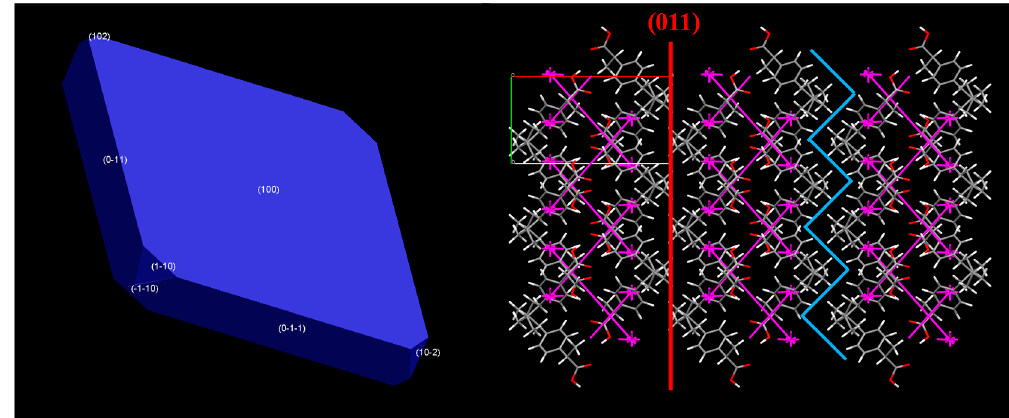
Figure 10. Growth morphology (attachment energy-based) of IBU crystals and energy vector diagrams (EVDs) depicting the total interactions in the unit cell, viewed along the c-axis.